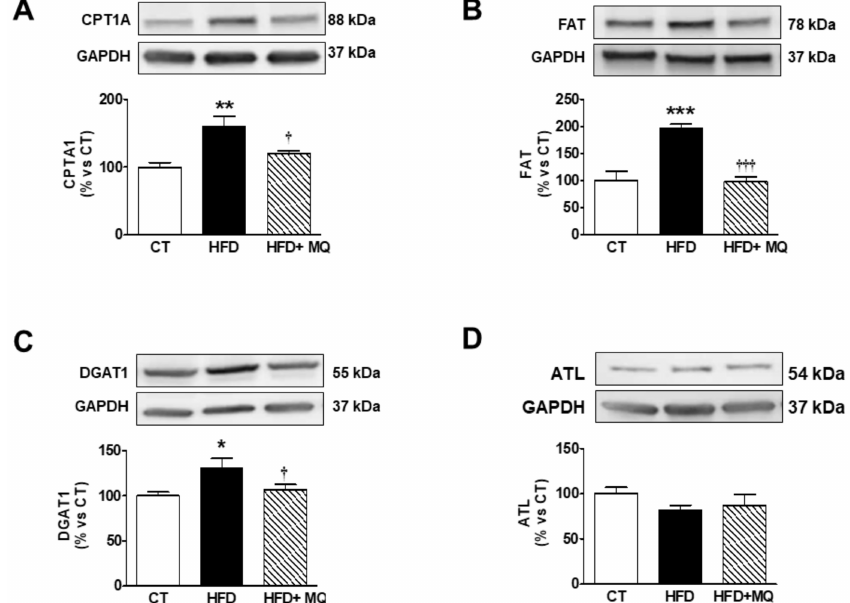
Figure 3. E ff ects of the mitochondrial antioxidant MitoQ (MQ) on protein levels in the hearts of obese rats. Hearts from rats fed a standard diet (CT) or a high fat diet (HFD) treated with vehicle or with MQ (200 µ M) were analyzed. Protein expression of ( A ) carnitine palmitoyltransferase 1 (CPT1A), ( B ) fatty acid translocase (FAT), ( C ) diacylglycerol transferase 1 (DAGT1) and ( D ) adipose triglyceride lipase (ATL) are presented. Bar graphs represent the mean ± SEM of 6–8 animals normalized to glyceraldehyde-3-phosphate dehydrogenase (GAPDH). * p < 0.05; ** p < 0.01; *** p < 0.001 vs. control group. † p < 0.05; ††† p < 0.001 vs. HFD group.